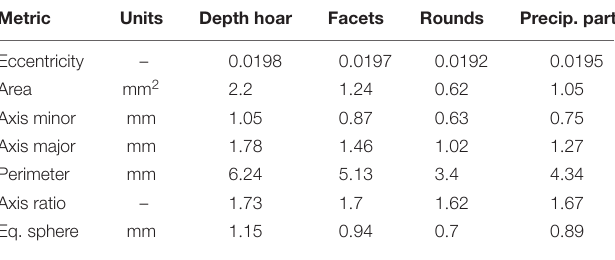
TABLE 4 | Snow metric averages for depth hoar, facets, rounds, and precipitation particles. Metric Units Depth hoar Facets Rounds Precip.